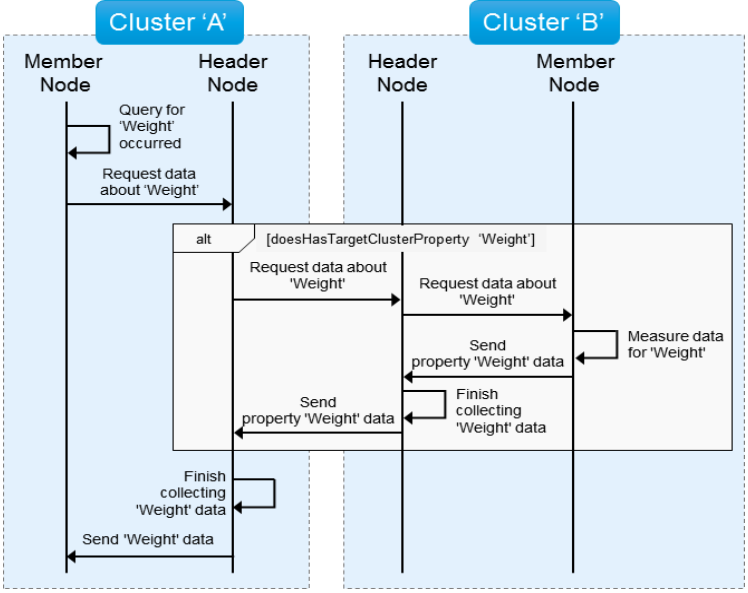
Figure 4. Data-exchange phase sequence diagram.